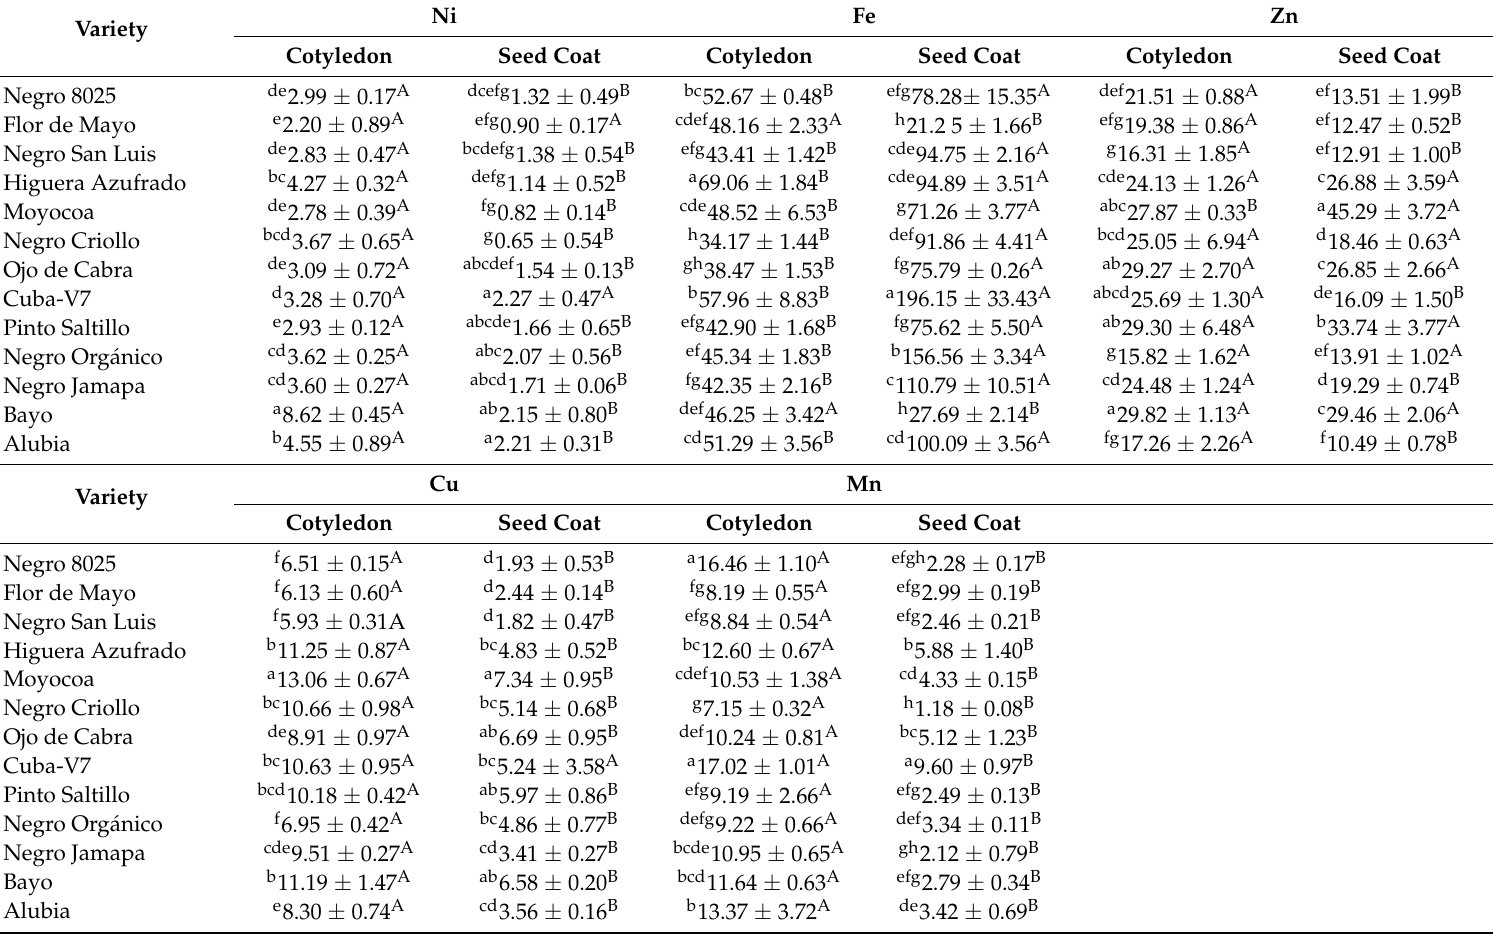
Table 4. Micronutrients content (ppm) in the seed coat and cotyledon of common bean varieties. Ni Fe Zn Variety Cotyledon Seed Coat Cotyledon Seed Coat